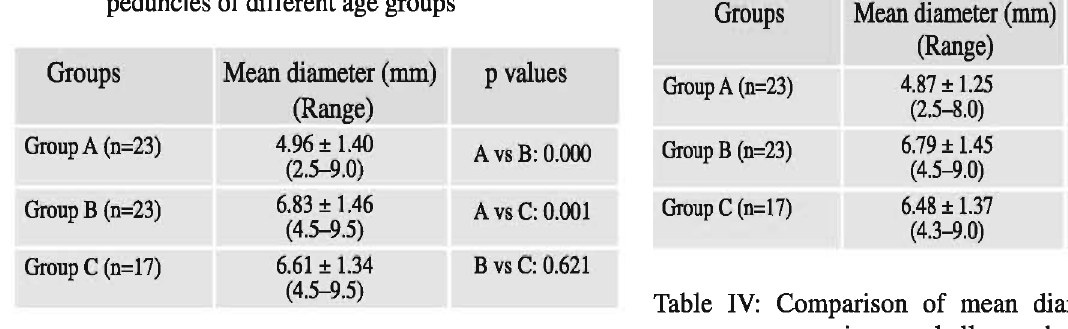
Table II: Comparison of mean diameters of right superior